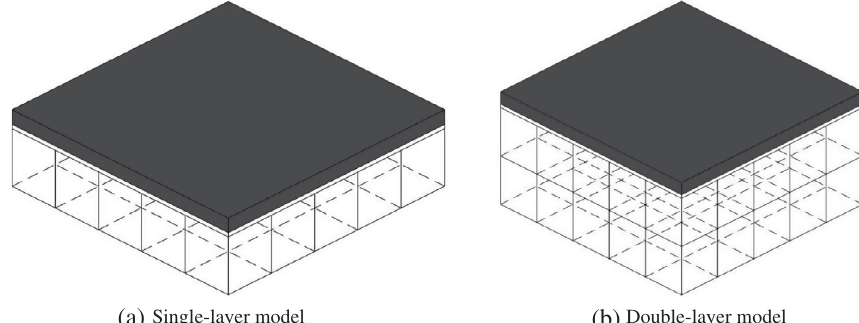
Figure 4. Two simple models used to evaluate the stress level in the ceramic shell.